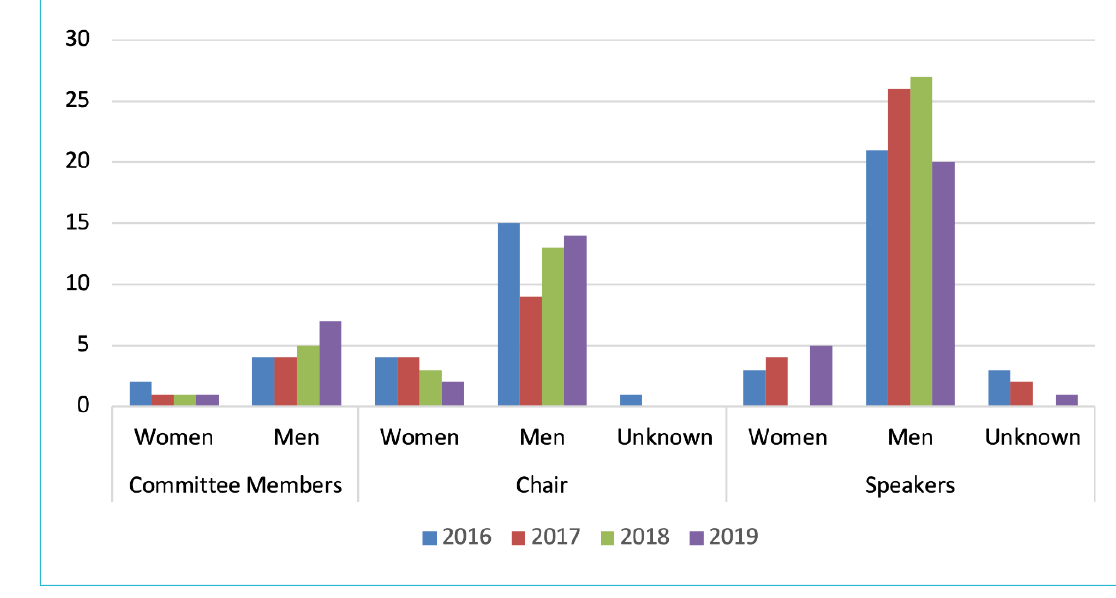
Figure 2: Gender distribution among committee members, chairs and speakers at the annual SSERM conferences in 2016, 2017, 2018 and